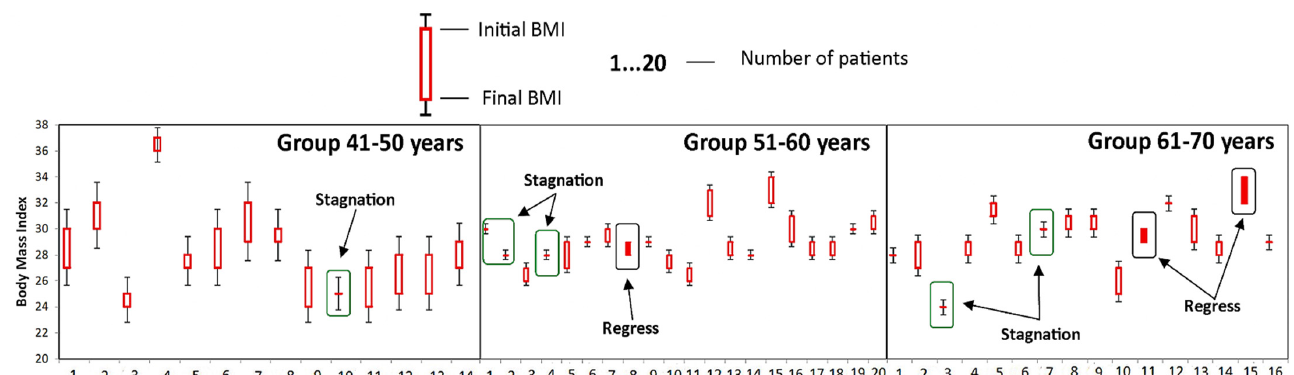
10 of 16 Table 5. The evolution of modifiable parameters the group A during the study by age criterion. Age (Years)